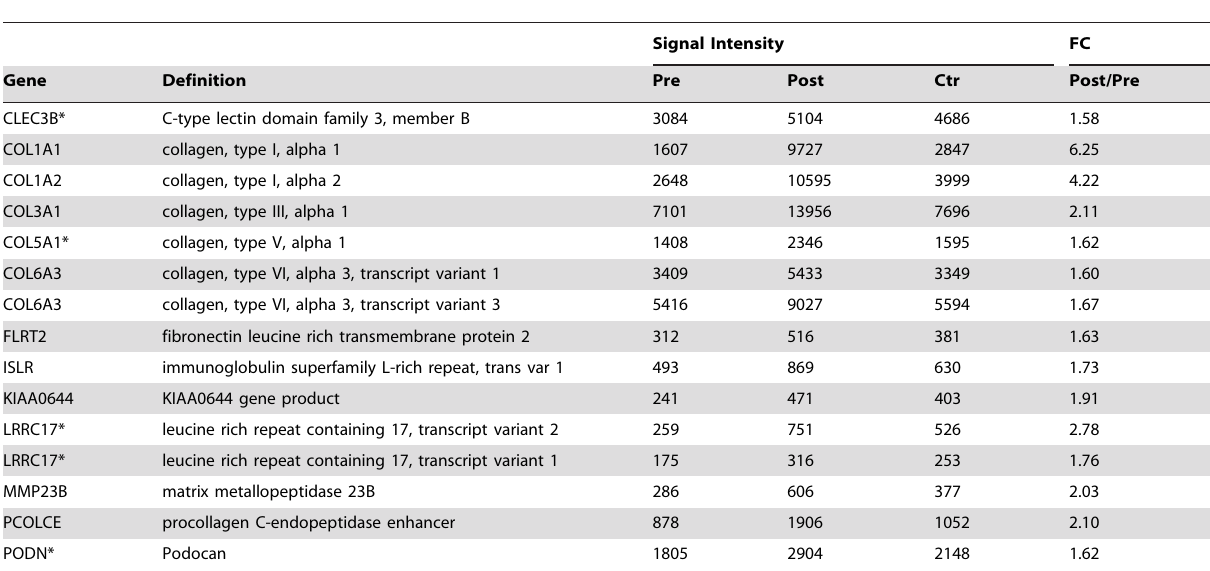
Table 4. Up-regulated genes in adipose tissue after profound fat loss (PANTHER category Extracellular matrix, q-value=0).